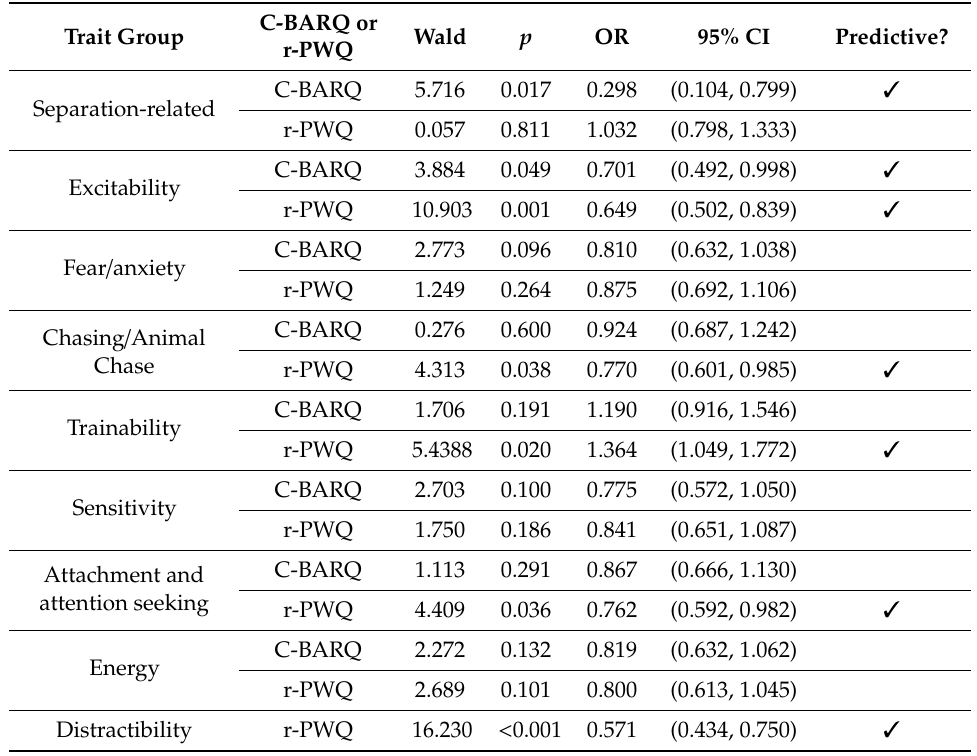
Table 6. The Wald Chi-square, odds ratio (OR), confidence intervals (CI) and the significance value for C-BARQ and PBQ trait scores as predictors for qualification as a guide